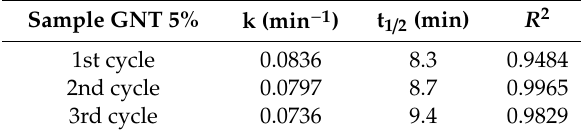
Table 3. Reusability performance of GNT5% catalyst.